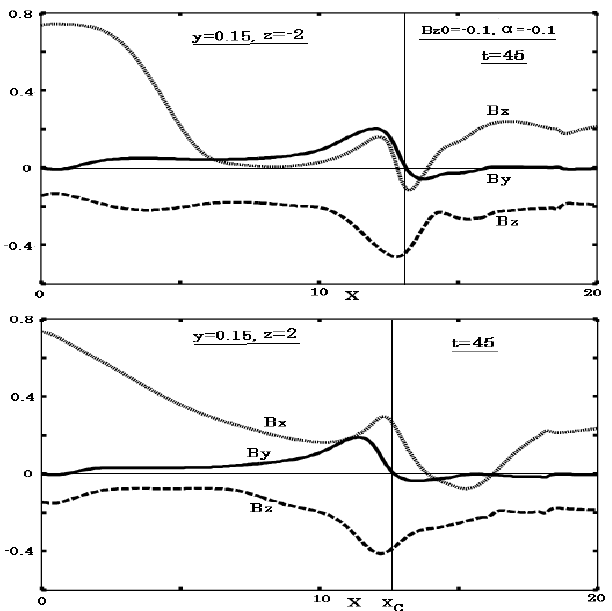
Fig. 11. x-directional profiles of magnetic field components B x ,B y Figure 11: x-directional proflles of magnetic fleld compo- and B z at y = 0 . 15 and z = − 2 . 0 and z = 2 at time t = 45 for the Figure 12: x-directional proflles of magnetic fleld compo- Figure 9: x-directional proflles of magnetic fleld components case of B z 0 =− 0 . 1 and α =− 0 . 1, where the plasmoid center X C is nents B x ; B y and B z at y = 0 : 15 and z = nents B x ; B y and B z at y = 0 : 15 and z = indicated. B x ; B y and B z at y = 0 : 15 and z = 1 : 0 at times t = 41 and 45 time t = 45 for the case of B z 0 = ¡ t = 44 and 48 for the case of B z 0 = for the case of B z 0 = 0 : 1 and fi = 0 : 1, where the plasmoid the plasmoid center X C is indicated. ¡ ¡ the plasmoid center X C is indicated. center X C is indicated.